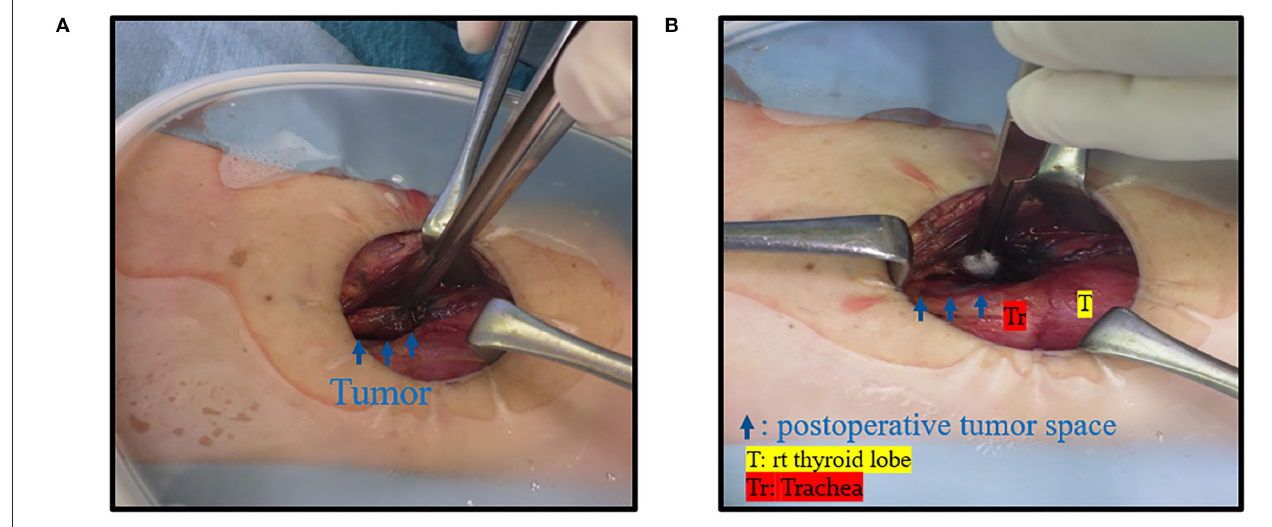
FIGURE 7 | Case 8. (A) Intraoperative finding; there was a mass near the right trachea (blue arrow). (B) There was a space after the tumor was